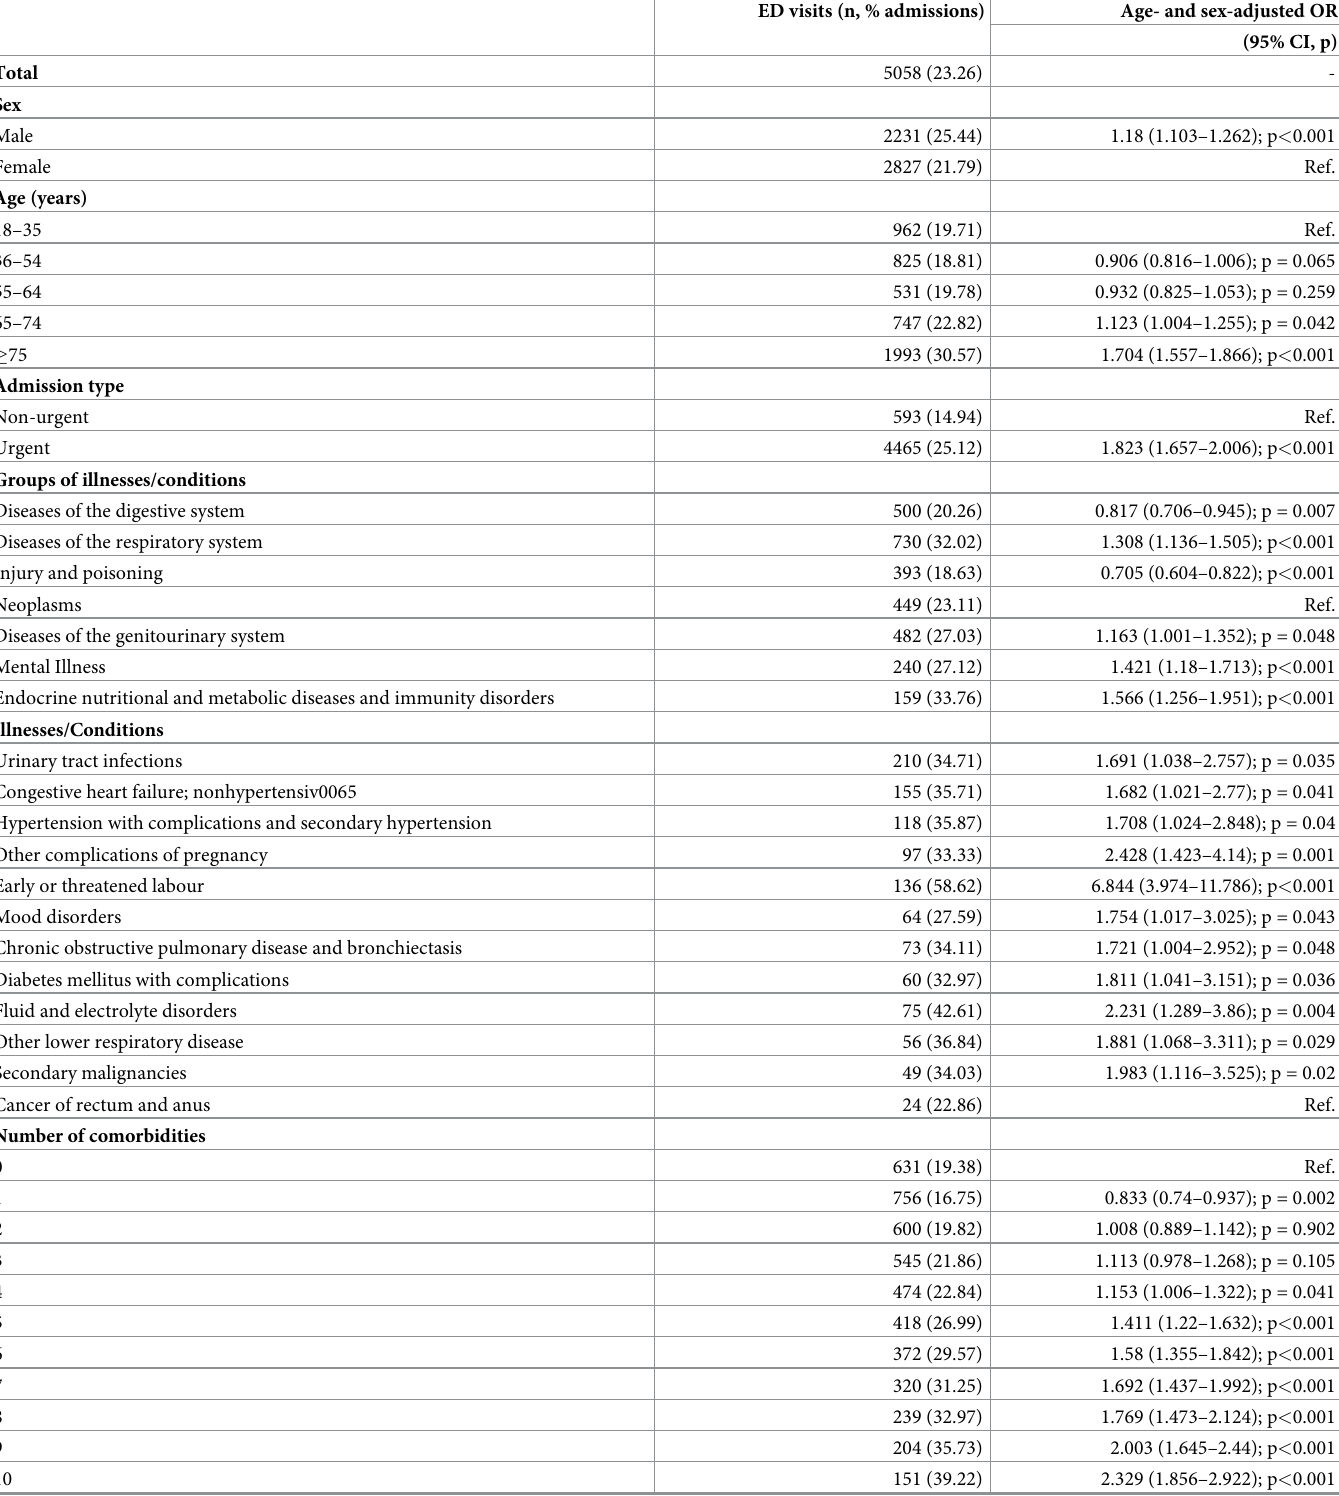
Table 2. Frequency of ED visits within 30 days after hospital discharge and age- and sex- adjusted